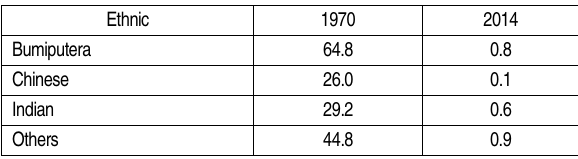
Table 2. Incidence of poverty by ethnic group in per- centage, Malaysia, 1970 and